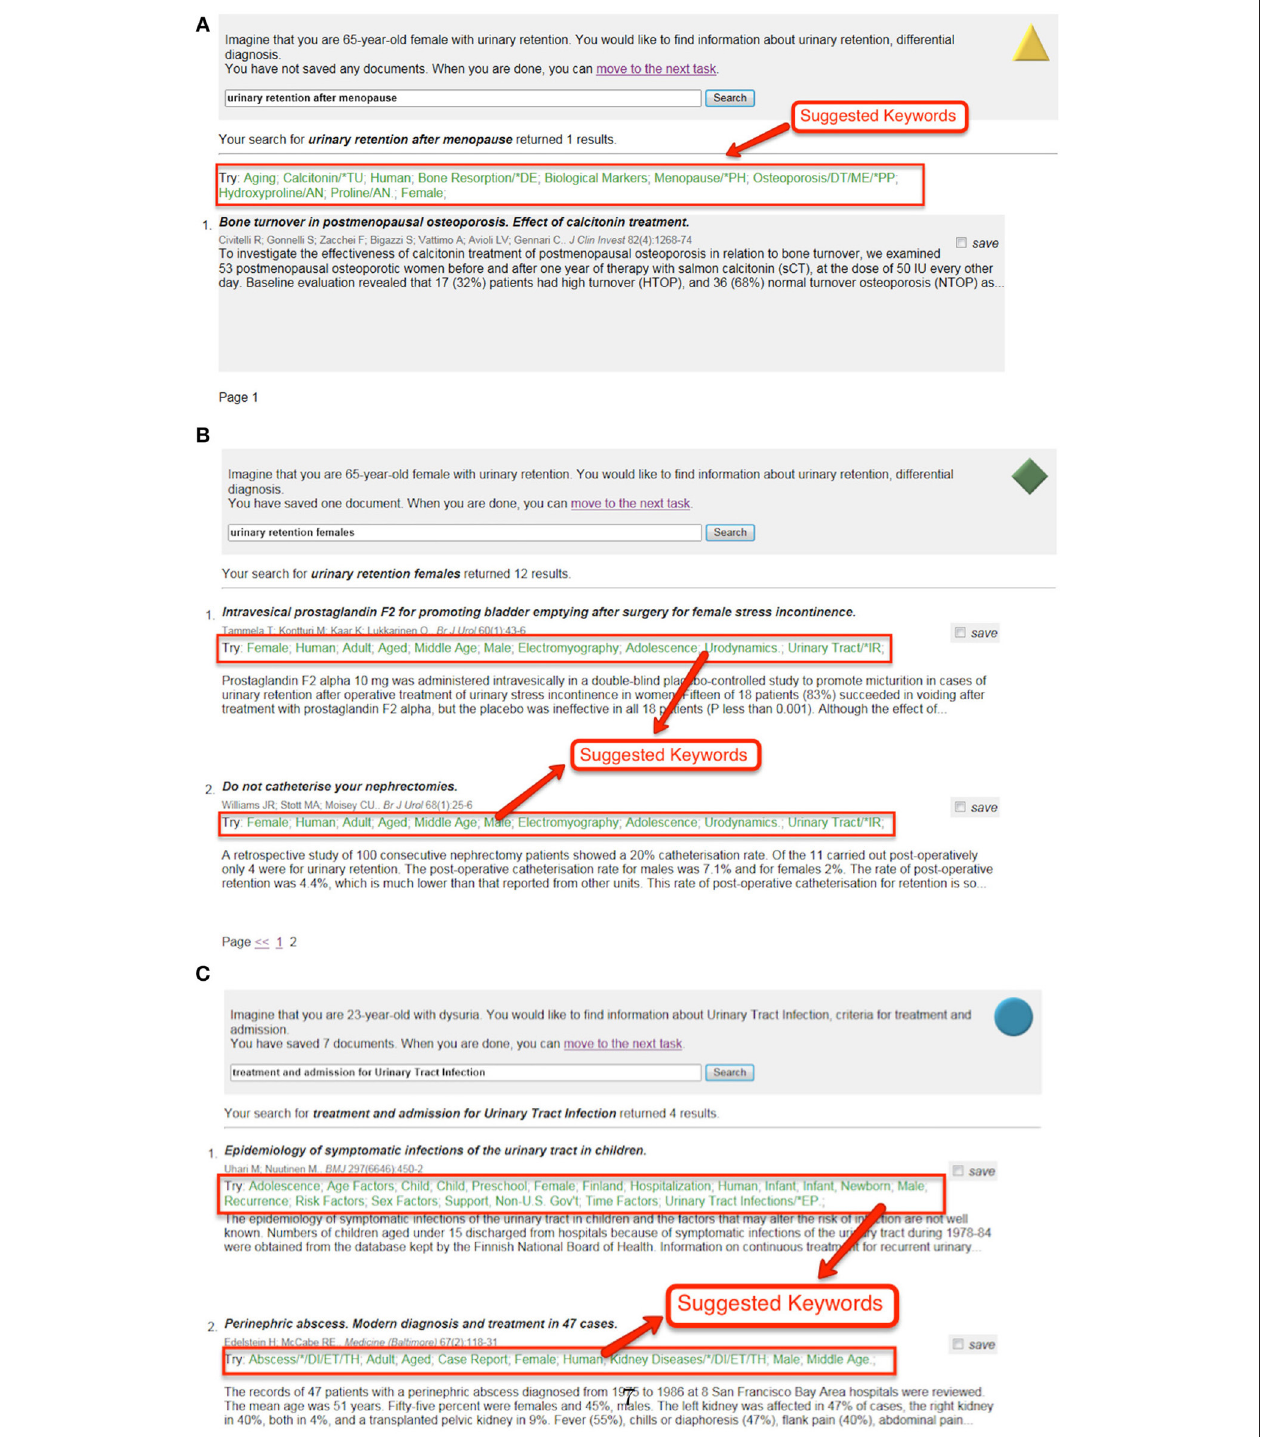
FIGURE 1 | Three of the four search interfaces in the study. (A) Screenshot of Interface “B,” suggestions per-query and displayed at top. (B) Screenshot of Interface “C,” suggestions per-query and displayed at top. (C) Screenshot of Interface “D,” suggestions per-document and displayed with the document.